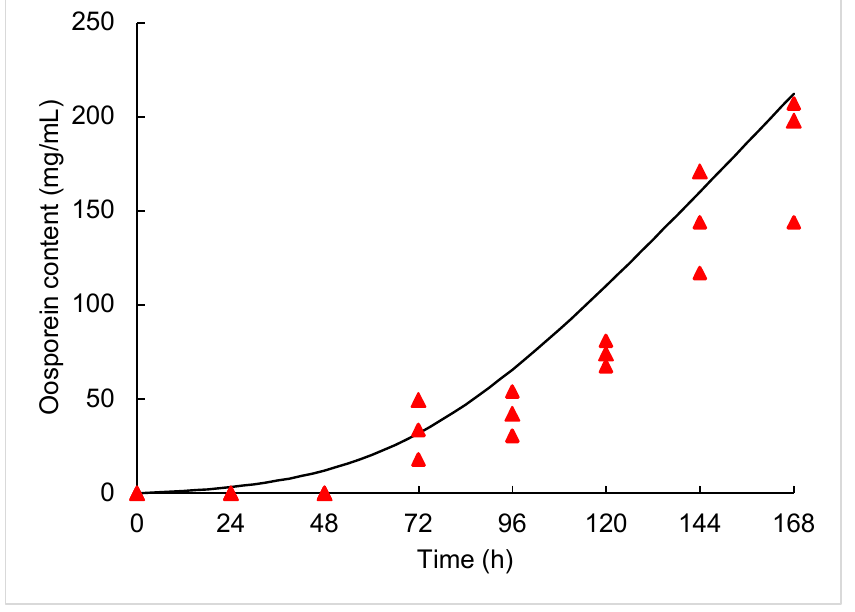
Figure 4. Kinetic production of oosporein by Beauveria bassiana PQ2 in biofilm bioreactor. Closed triangles are the experimental data, and the continuous line represents the data predicted by the model.